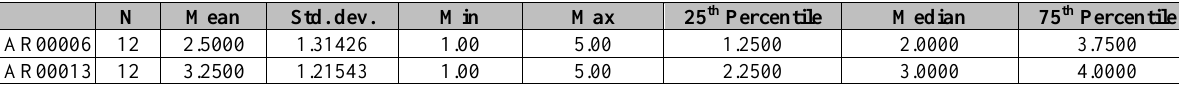
Table 12. Difficulties in Getting Information and Data about Supply Chain Arrangements (Descriptive